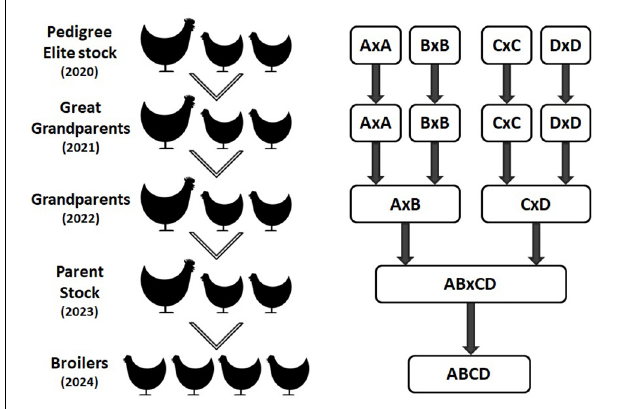
FIGURE 4 | In study 2 a high generation broiler was produced by using great grandparents as parent stock by crossing pedigree pure lines (right dashed box). The high generation broiler can then be compared to the current commercial broiler (left dashed box) to see the impact of genetic selection for a trait of interest such as wooden breast. The generational difference between the two broiler groups represents 2 years of genetic